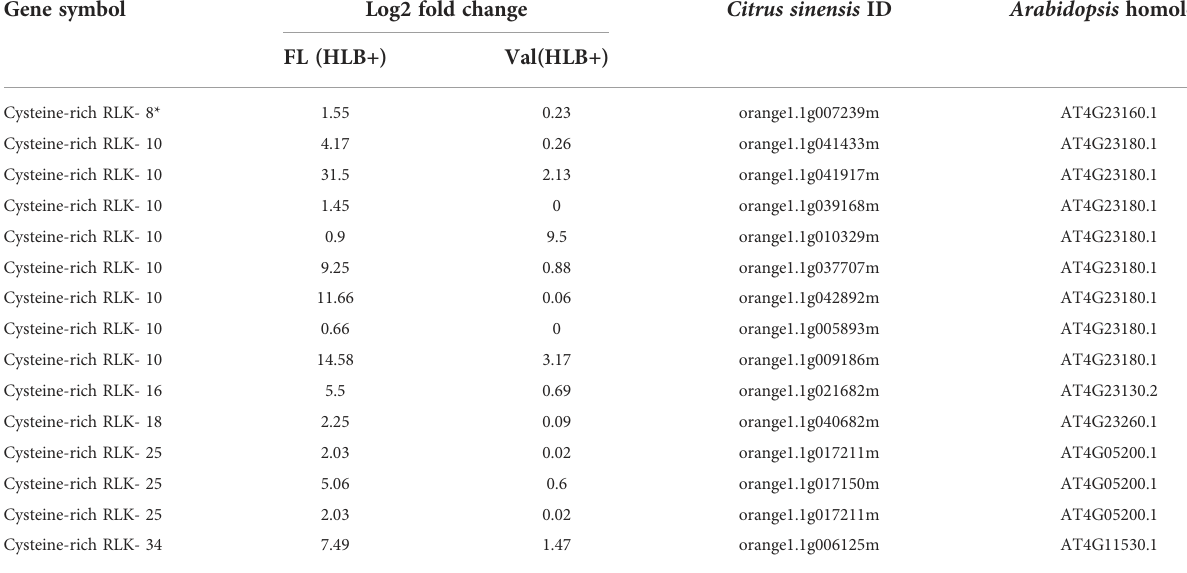
TABLE 3 DEGs involved in cysteine-rich receptor-like protein kinase of Ca Las infected fi nger lime and ‘ Valencia ’ sweet orange. Gene